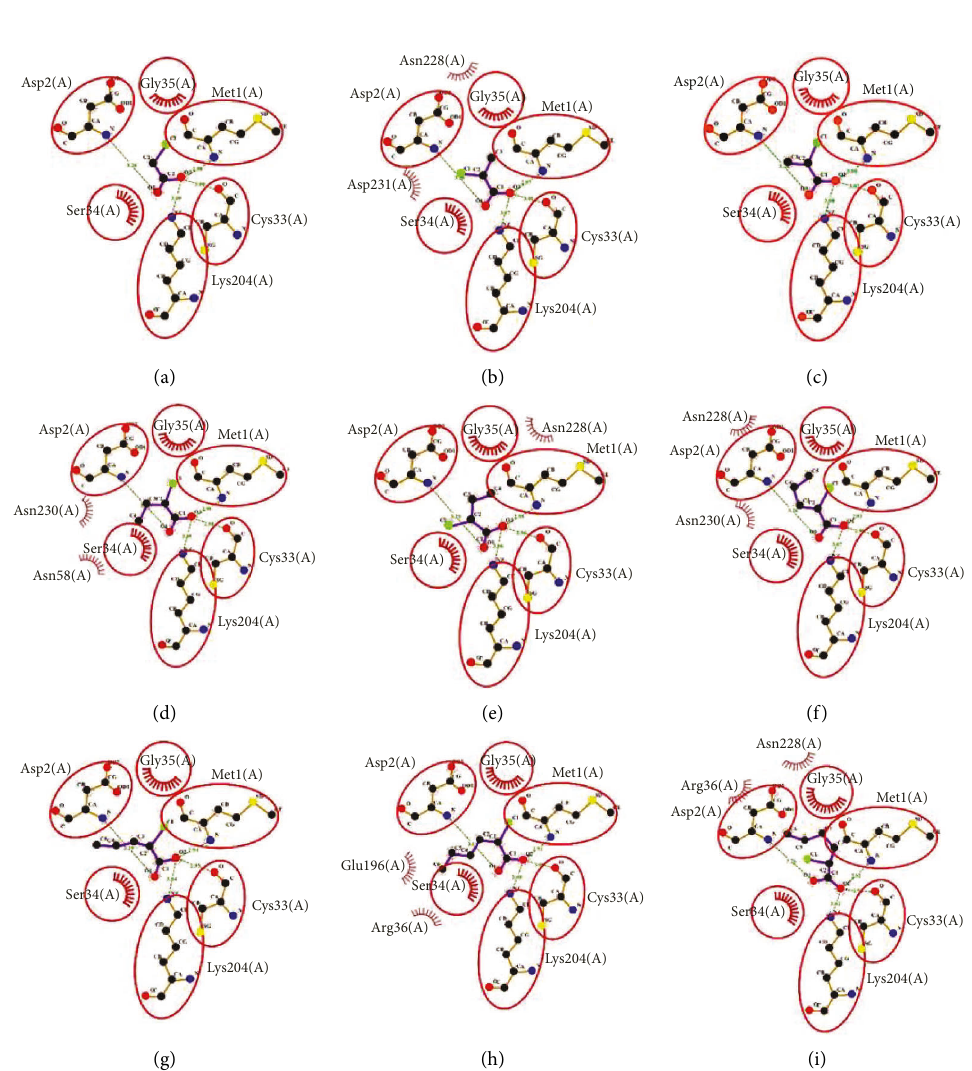
Figure 4: Schematic interaction of residues in the active site of Bcfd1 with chloroalkanoic acids. (a) MCA. (b) L2CP. (c) D2CP. (d) L2CB. (e) D2CB. (f) L2CPn. (g) D2CPn. (h) L2CH. (i) D2CH. Four residues (Met1, Asp2, Cys33, and Lys204) form hydrogen bonds with ligands orienting its carboxylate groups to the same direction that indicates the important role of these four residues of the Bcfd1 active